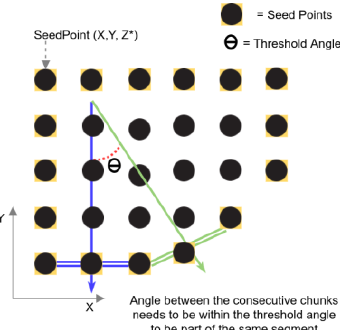
Figure 6. Localized sliding window movement of chunks for segment identification